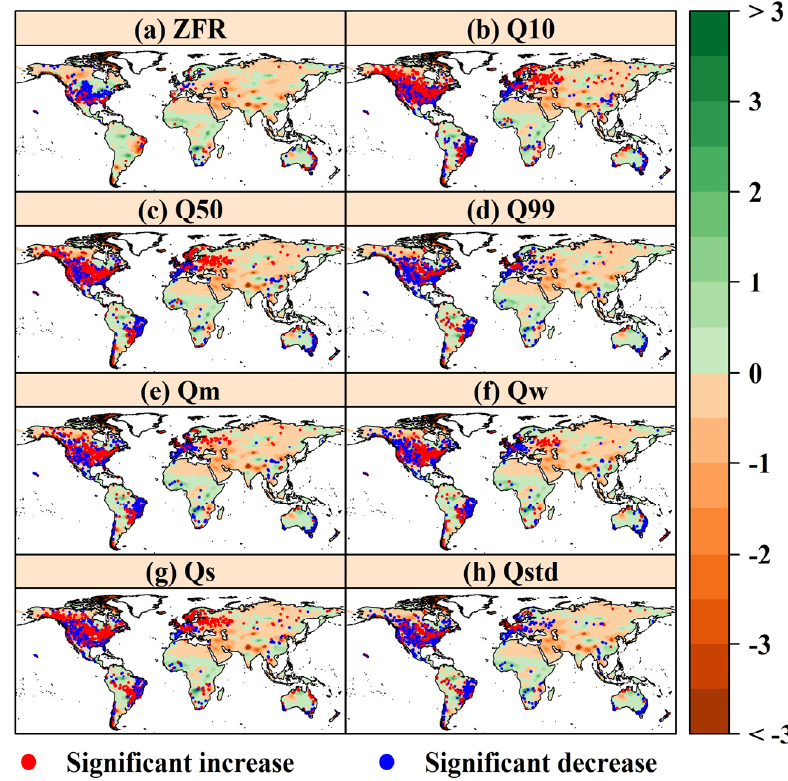
Figure 5. Spatial patterns of trends in eight runoff signatures, ( a ) ZFR, ( b ) Q10, ( c ) Q50, ( d ) Q99, ( e ) Qm, ( f ) Qw, ( g ) Qs, ( h ) Qstd based on the Mann–Kendall test at the 0.05 significance level, as well as trends in GRACE liquid water equivalent thickness in cm/year (1979–2017). The red circles indicate increasing trends, the blue represents decreasing trends. The green in the background shows an increasing trend in liquid water equivalent (basin water storage), and the orange shows a decreasing trend. The darker the color, the more obvious the changing trend.